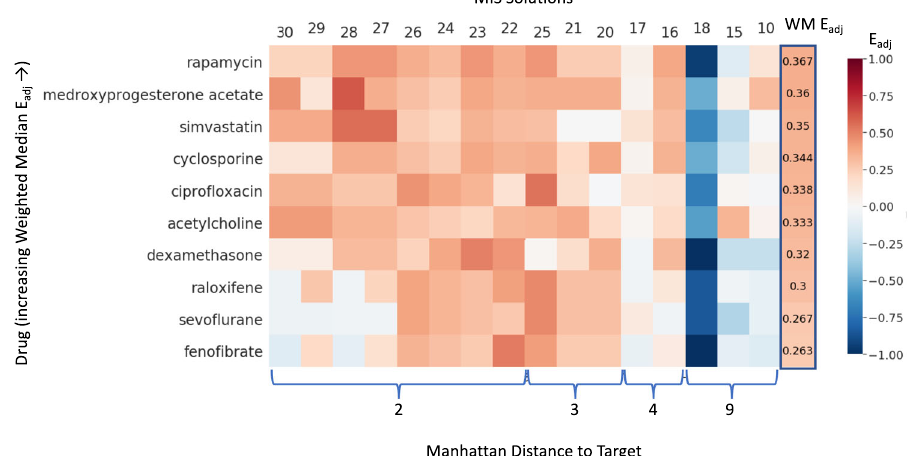
Fig. 3 Ranking single drugs. Adjusted enrichment E adj values obtained in each of the 16 signi fi cantly actionable MIS interventions (empirical null distribution p( A(s) ) < 0.05) computed for the individual drugs with the top ten highest overall weighted median adjusted enrichment (WM E adj ). Drugs are ordered along the vertical axis by increasing weighted median E adj and MIS solutions along the horizontal axis by increasing residual Manhattan distance (bits) separating the treatment outcome from the target healthy resting drug combination the adjusted enrichment E adj in each of the 16 signi fi cantly actionable intervention sets. Of the 144 FDA-